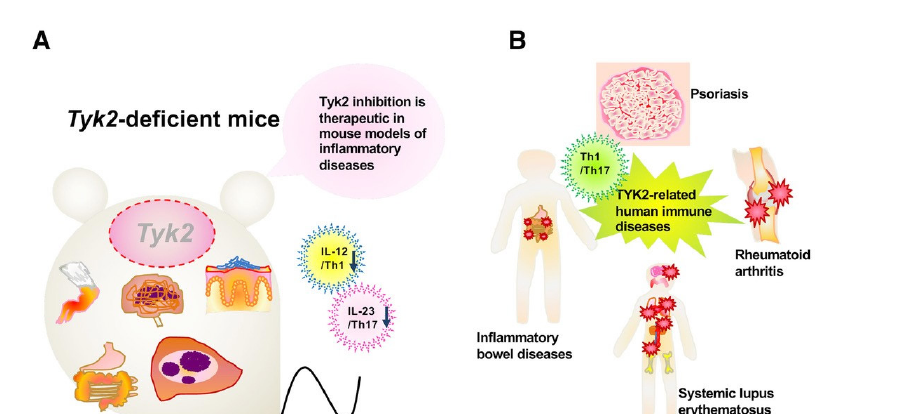
Figure 1. Tyk2 in various immune responses and its pathological significance. A. A schematic illustration of participation of Tyk2 in various experimental models utilizing Tyk2 -deficient mice; B. a schematic diagram of participation of TYK2 in its pathological significance in